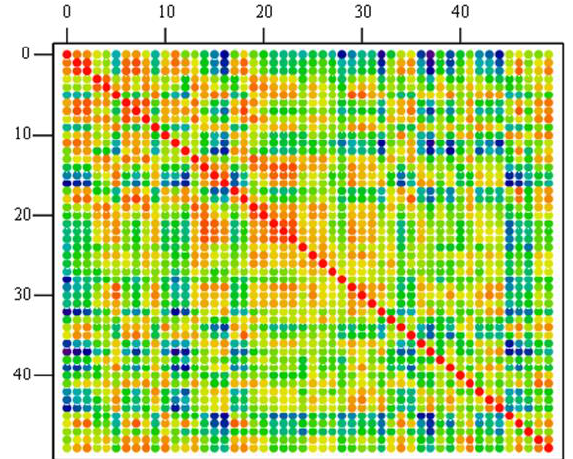
Figure 4. Example of a correlation matrix of 50 repetitions